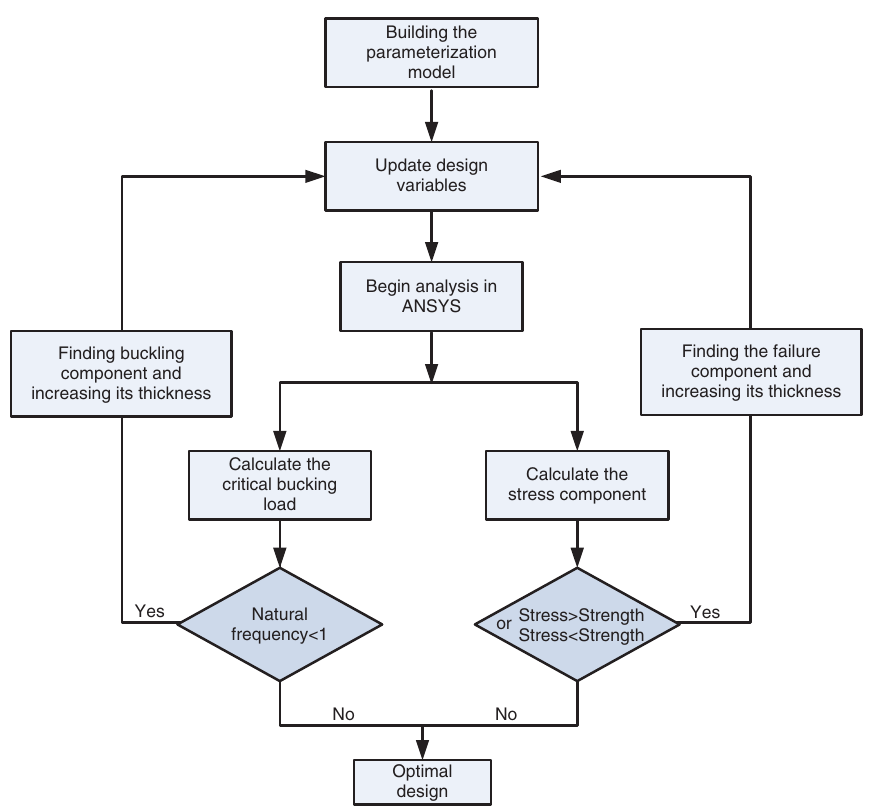
Figure 4: Optimal design procedure flow chart.